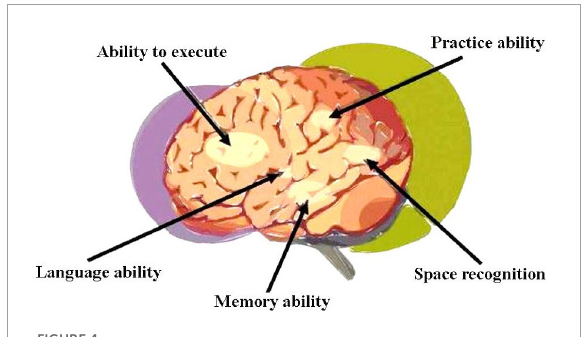
FIGURE4 Functional regions (vascular control areas) involved in cortical